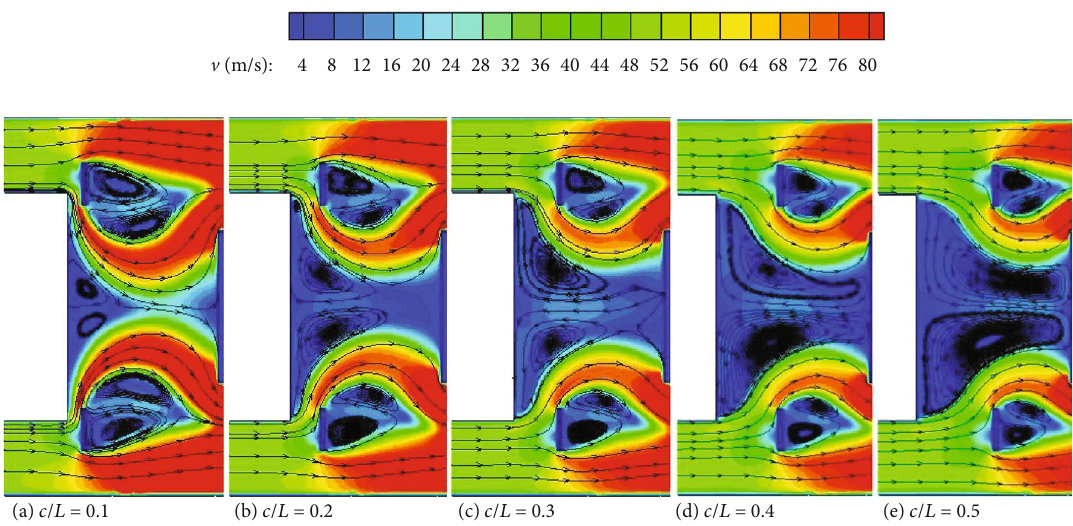
Figure 13: Velocity distribution at section Z = 0 mm under di ff erent c / L .